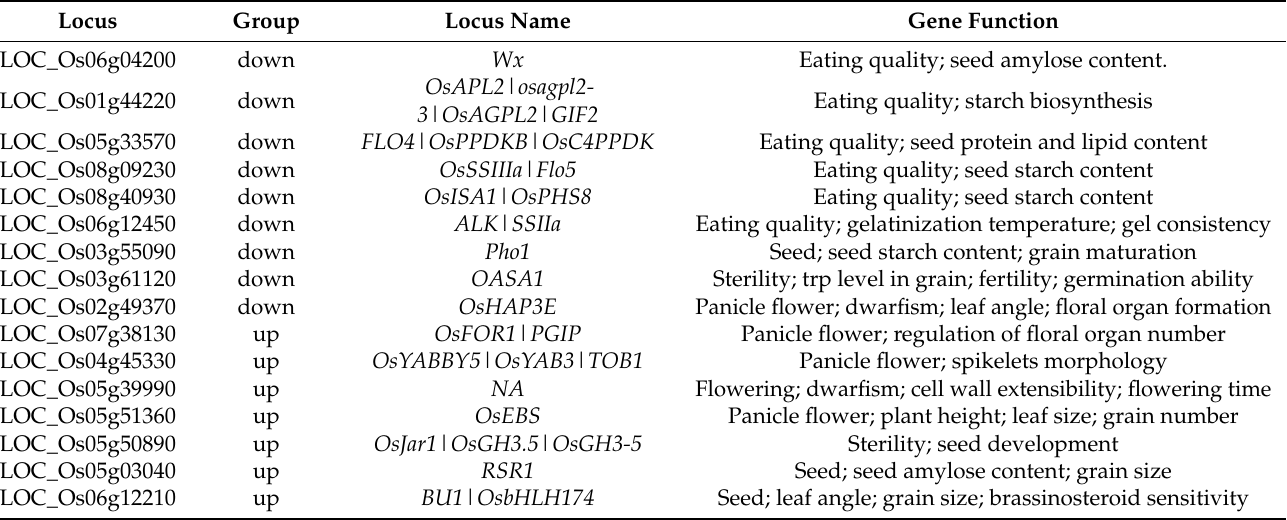
Table 5. The overlapping genes differentially expressed of LLYHZ compared with JLYHZ, and LLYHZ compared with JLY1212 in spikelets at flowering